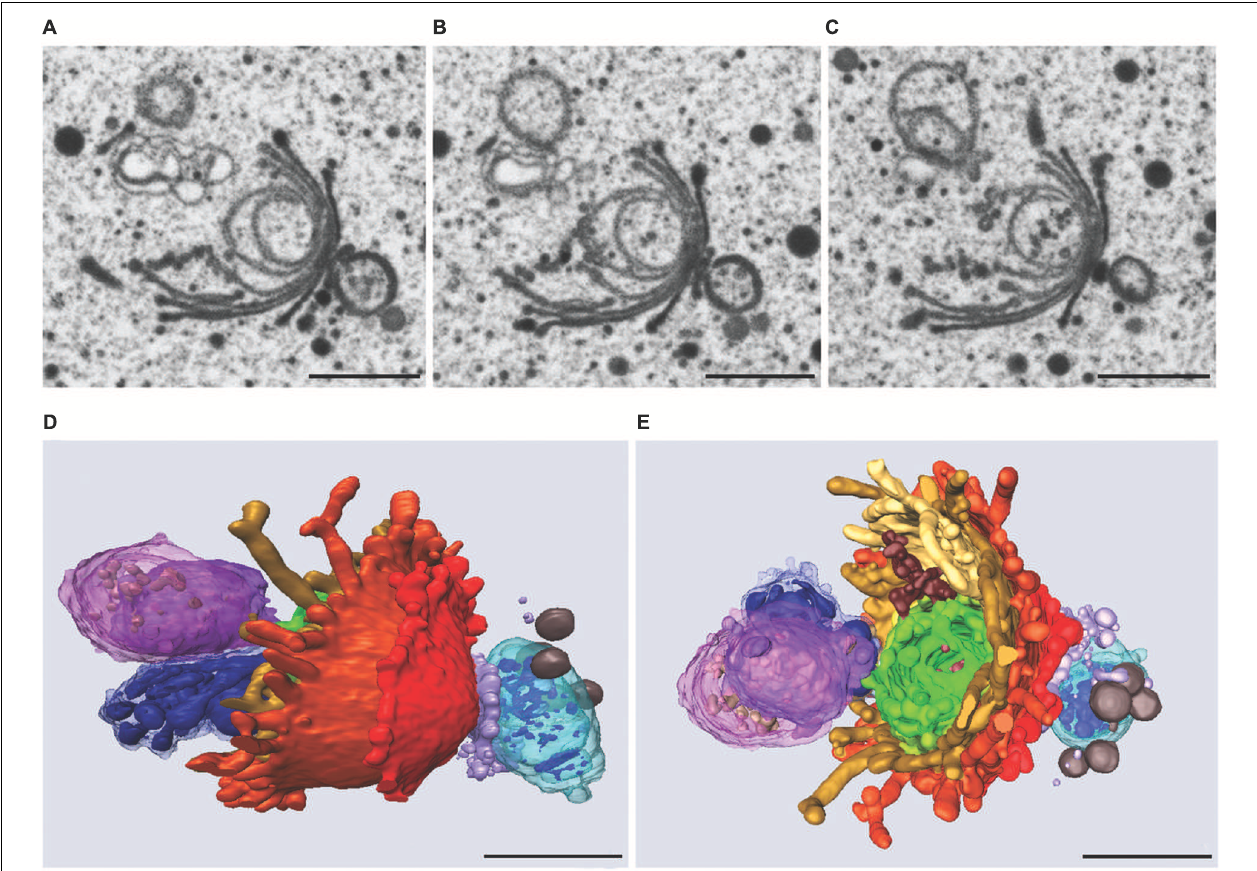
FIGURE 10 | Dictyosome of Micrasterias after exposure to CdSO 4 . (A–C) Images from FIB-SEM series. (D,E) Different views of corresponding 3-D reconstruction. Dictyosomal cisternae from cis- to trans- side: light blue to violet. Cisternae form balls at cis - and trans -side, abnormal ER displayed in dark blue. Scale bars are 1 µ m. Reprinted with permission from Lütz-Meindl et al. (2015), Copyright © 2015 Royal Microscopical